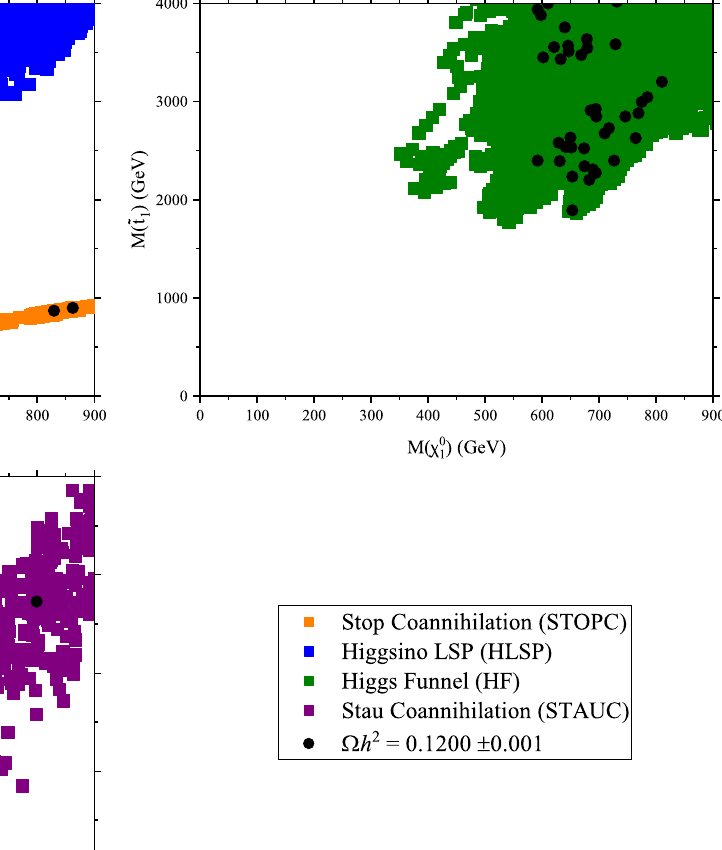
of these two significant regions. All points plot satisfy the light Higgs boson mass and relic density observations we outlined in this work, in addition to rare decay and current LHC SUSY search constraints. The round black dots represent those points that can also satisfy the recent 2018 Planck Collaboration satellite relic density measurements of (cid:9) h 2 = 0 . 120 ± 0 .